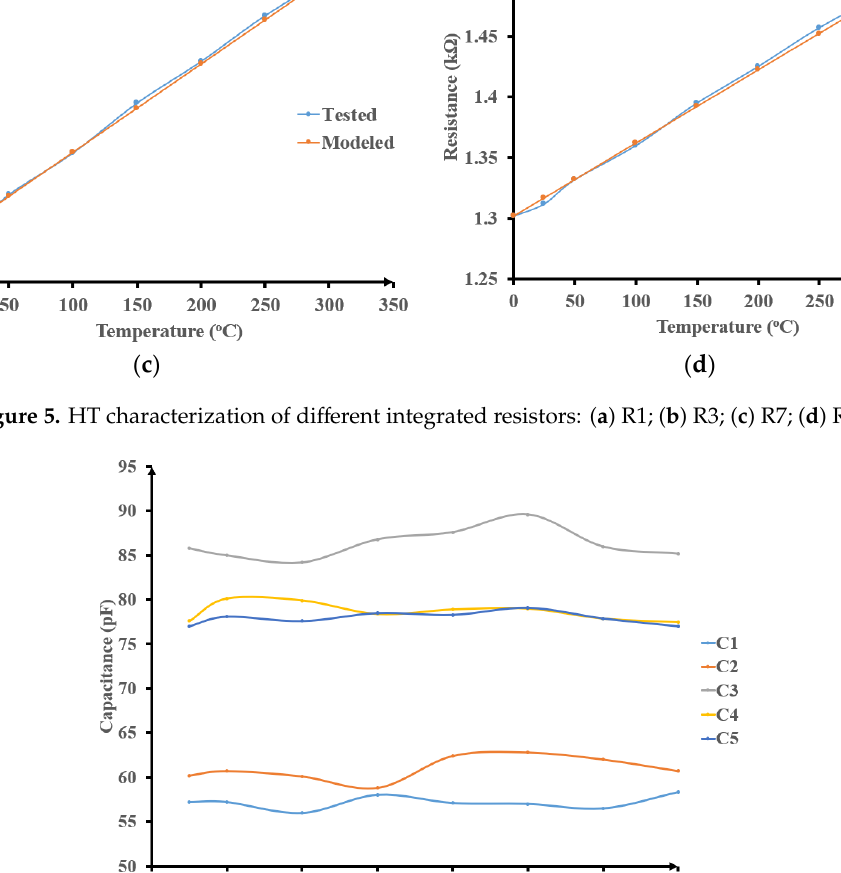
Figure 6. HT characterization of different integrated capacitors.